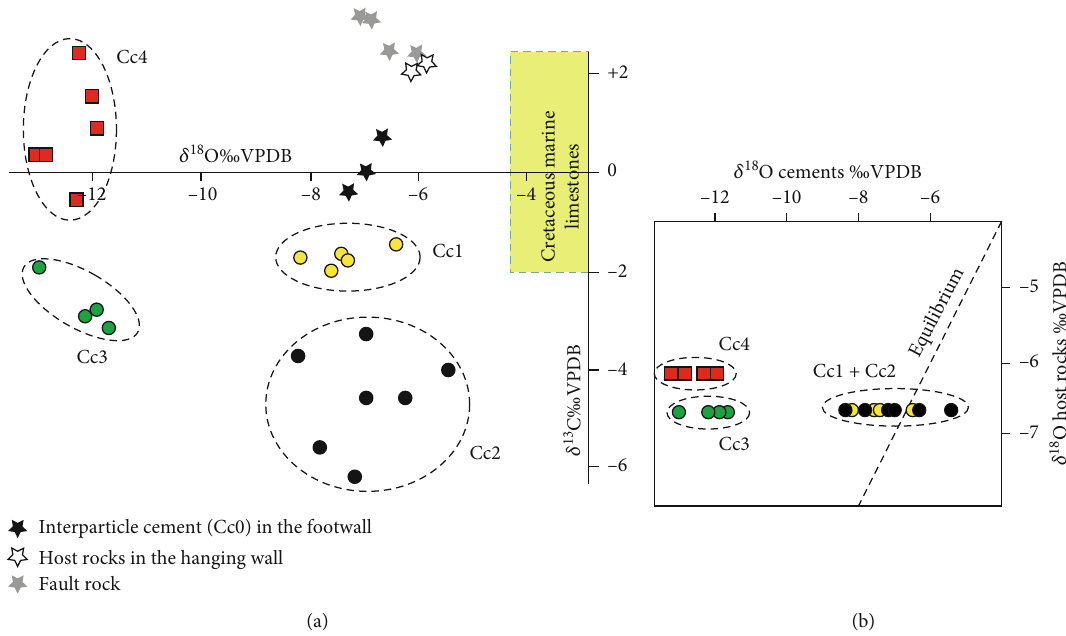
Figure 9: (a) Crossplot showing the δ 18 O and δ 13 C compositions of the calcite cements, host rocks, and fault rocks (carbonate matrix from the cataclasite). Cretaceous marine limestone values (green box) are from [53]. (b) δ 18 O values of the calcite cements versus δ 18 O values of the related host rocks.